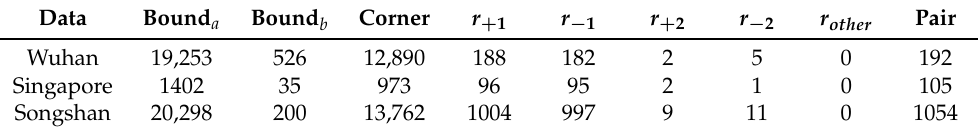
Table 2. Number statistics of boundaries, corners, residues, and pairs in the experimental